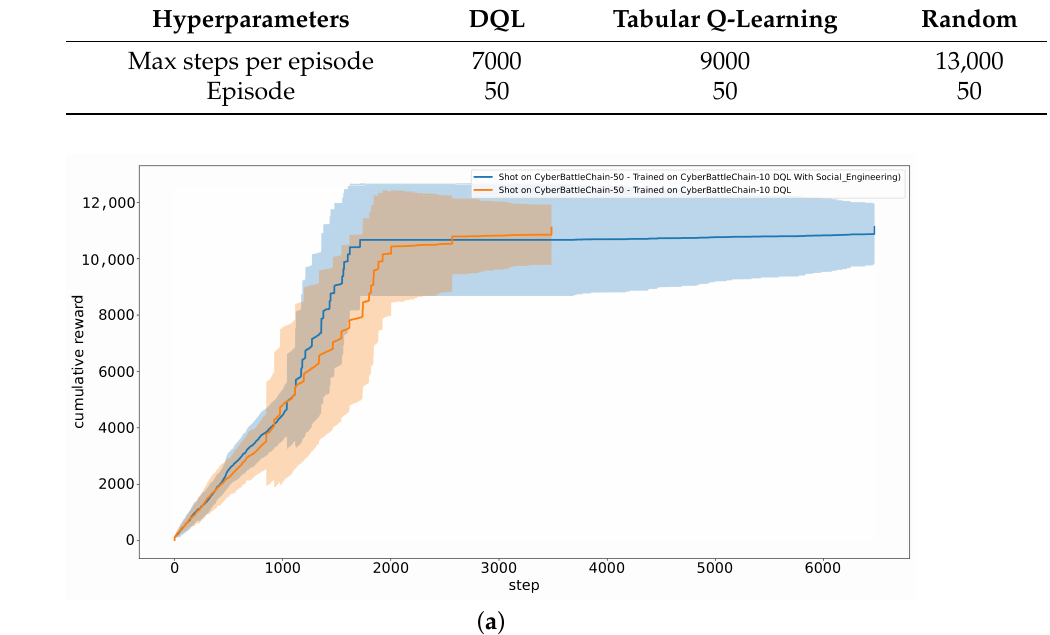
Table 9. Hyperparameter setting of Experiment C.